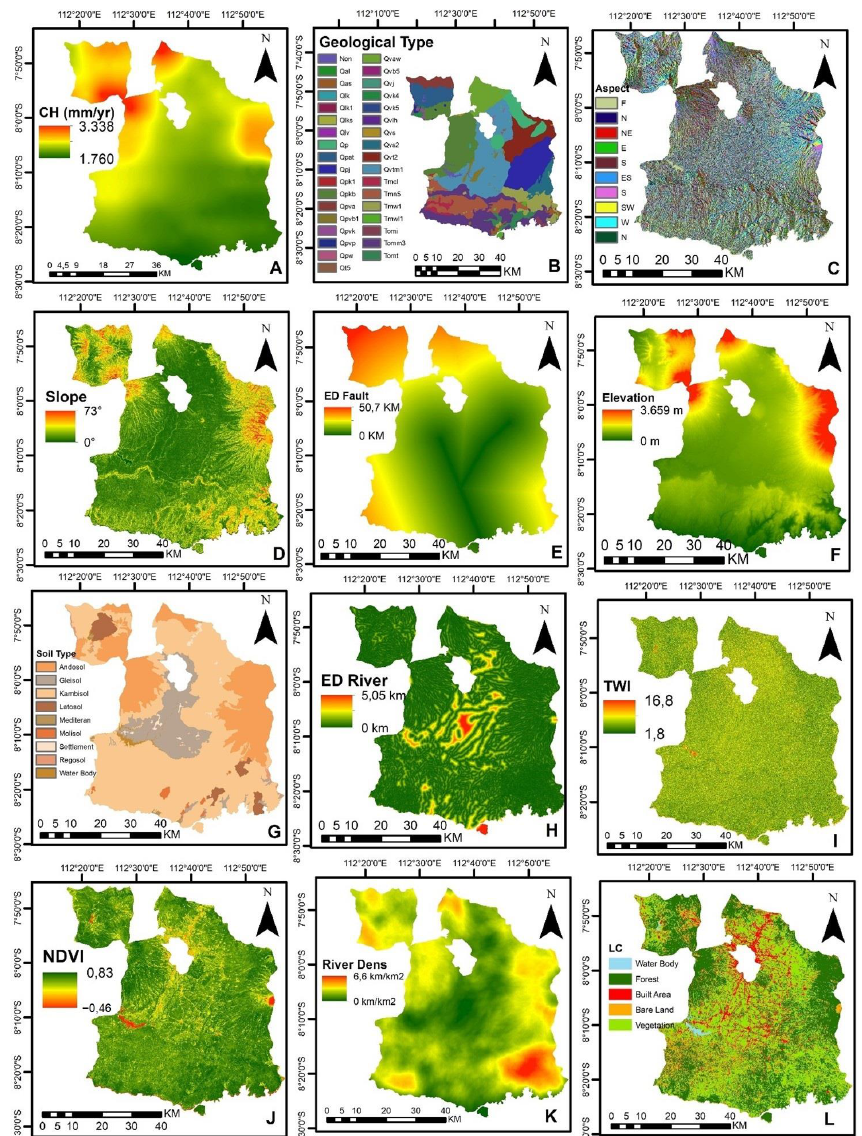
Figure 2. Landslide conditioning factors; ( A ) annual rainfall; ( B ) geological type; ( C ) aspect; ( D ) slope; ( E ) distance to fault; ( F ) elevation; ( G ) soil type; ( H ) distance to river; ( I ) TWI; ( J ) NDVI; ( K ) river density; ( L ) land cover.